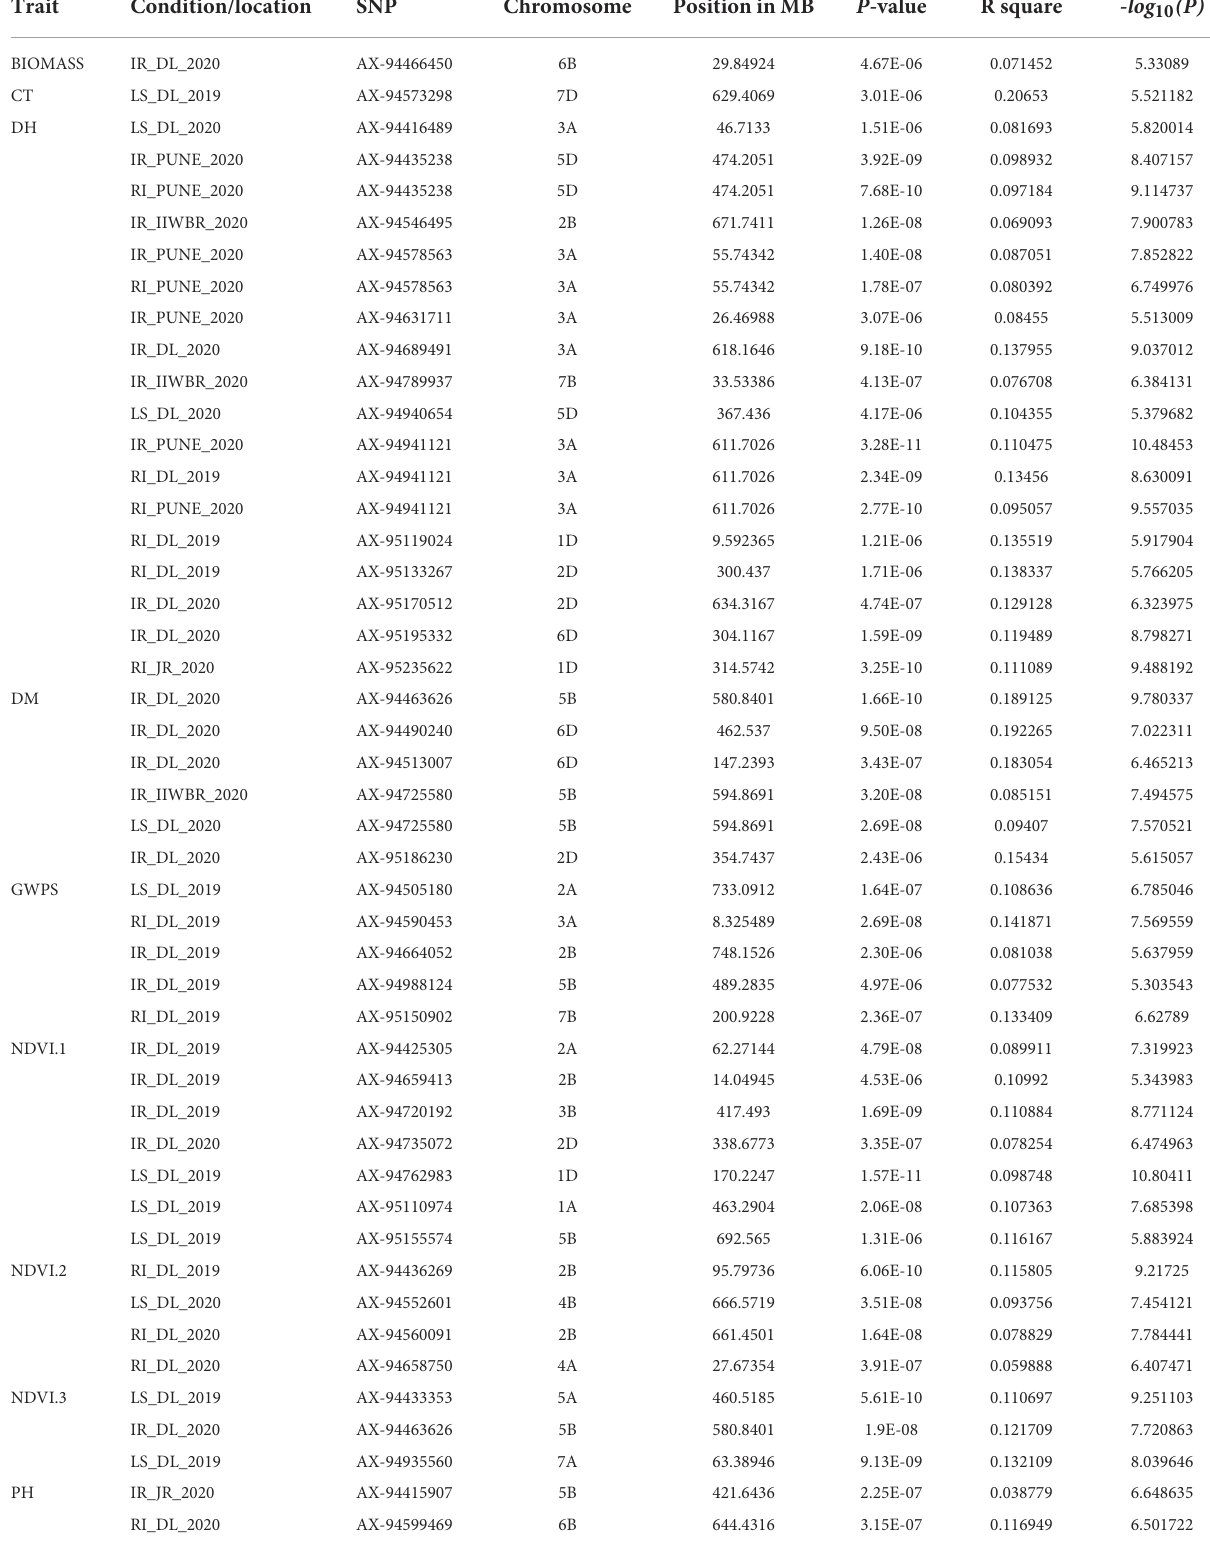
TABLE 4 Significant marker trait associations at Bonferroni corrected p value for traits under study at each environment.